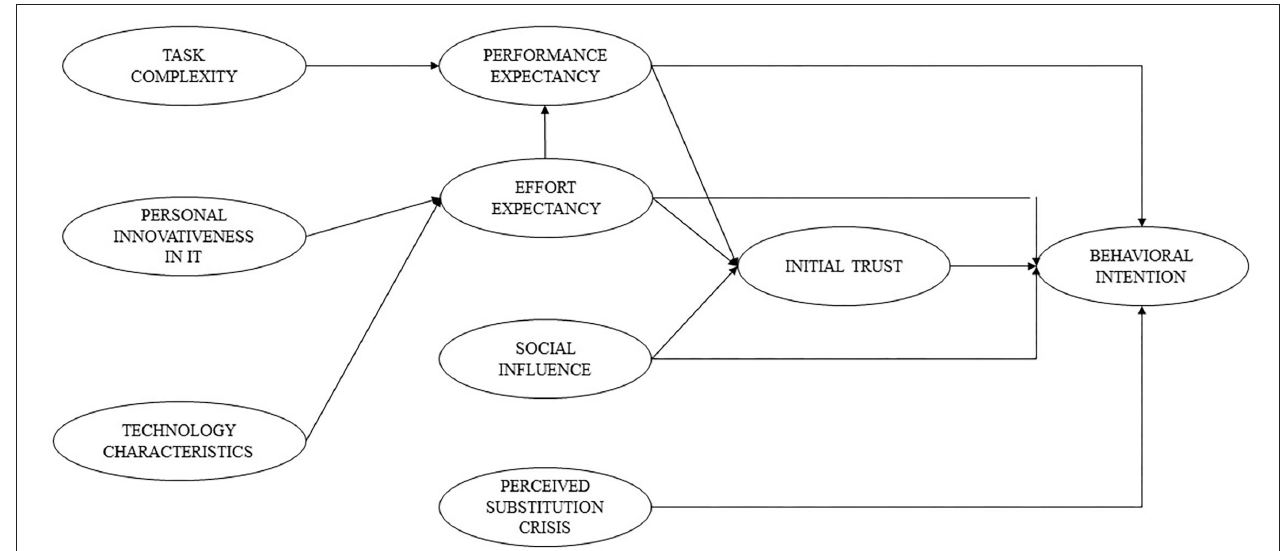
FIGURE 1 | A theoretical model to explore trusts and intentions to use AI-based diagnosis support